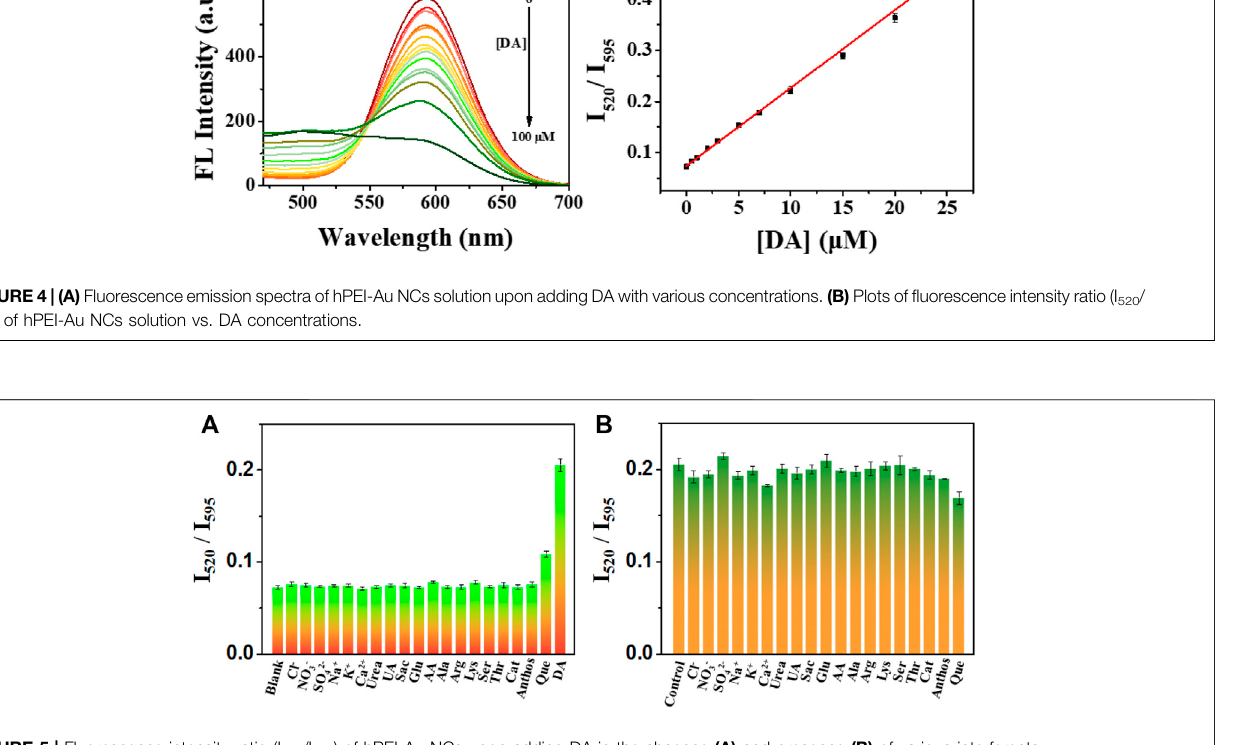
FIGURE 5 | Fluorescence intensity ratio (I 520 /I 595 ) of hPEI-Au NCs upon adding DA in the absence (A) and presence (B) of various interferents.